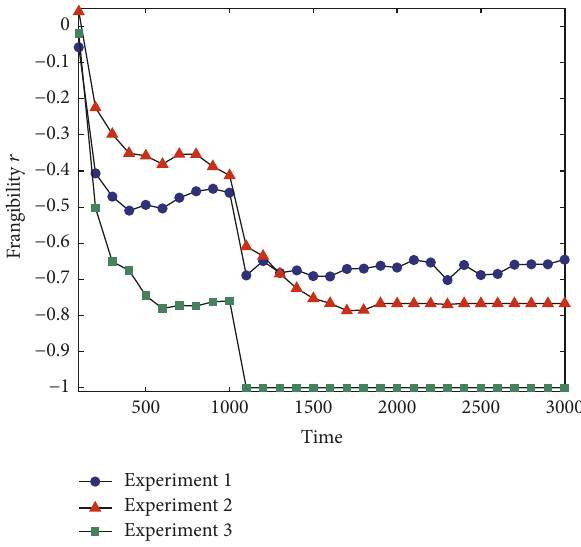
Figure 4: Evolution of the frangibility in social consensus system under government shielding